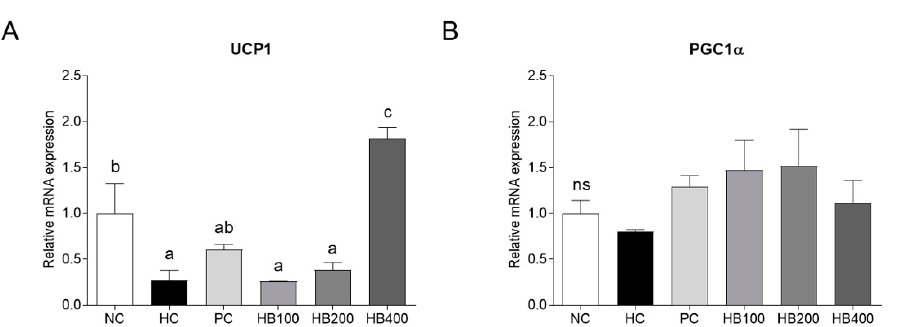
Figure 4. Effects of HB on the expression levels of genes related to thermogenesis in the epididymal fat tissue of HFD-fed mice. All data are mean ± SD. Significant differences among six groups are expressed as different letters based on one-way ANOVA ( p < 0.05), followed by Duncan’s multiple range tests.